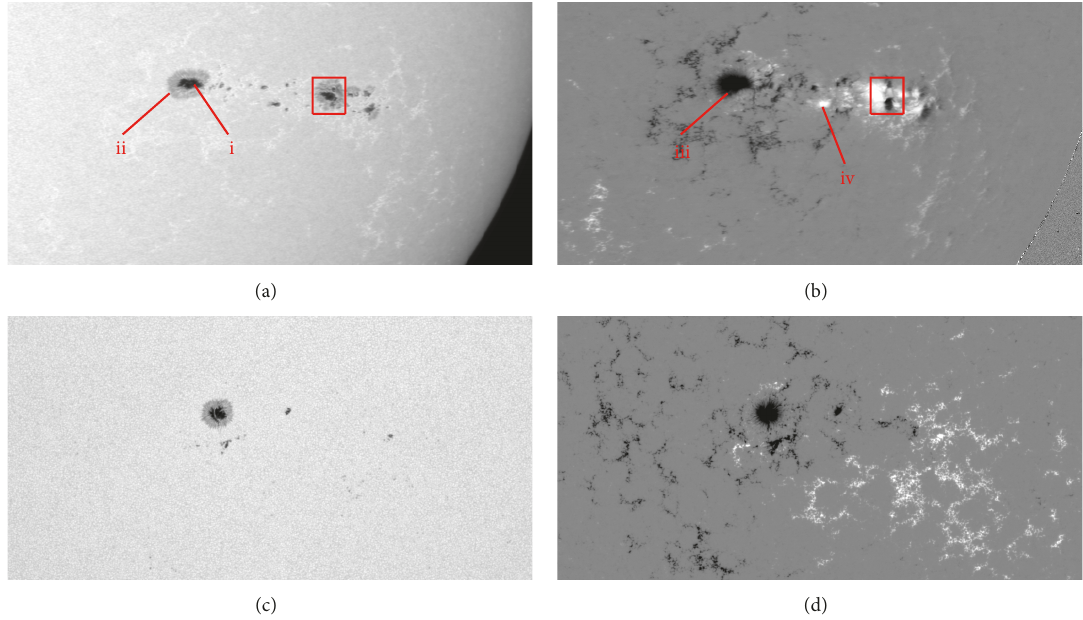
Figure 4: Two cases of misidentification of Beta-x as Beta in model B. (a) and (c) are the continuum images, whereas (b) and (d) are the magnetograms of the same ARs. In continuumimages, the dark centeris the umbra (i) and a lighterblack part around umbra is the penumbra (ii). In magnetograms, the dark areas indicate the negative polarity (iii) region, and the bright areas indicate the positive polarity (iv)